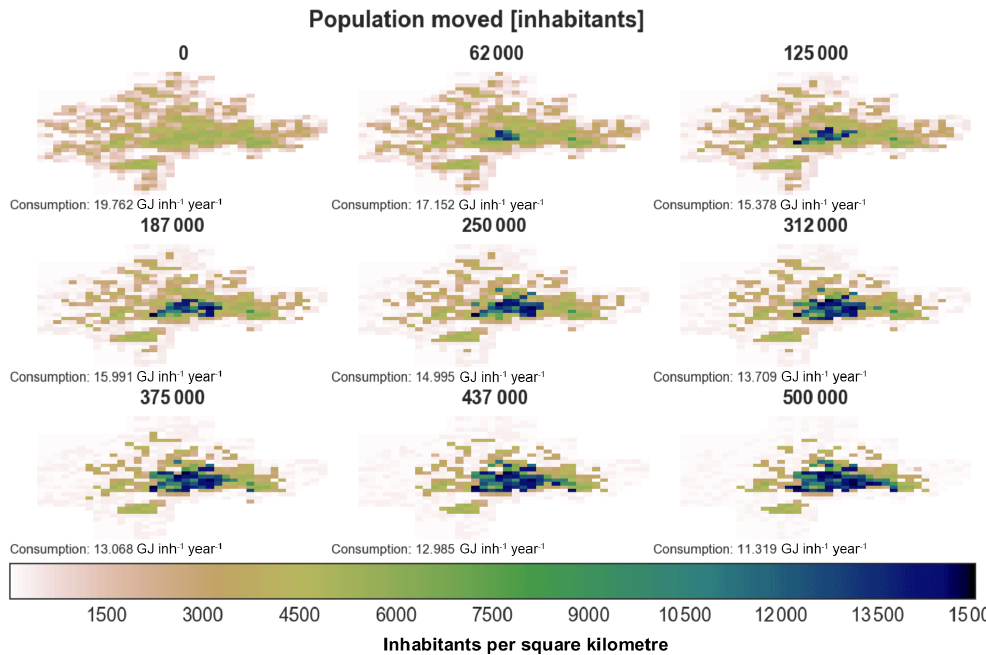
Figure 8. Evolution of the transformation of the urban form of Frankfurt using the probabilistic